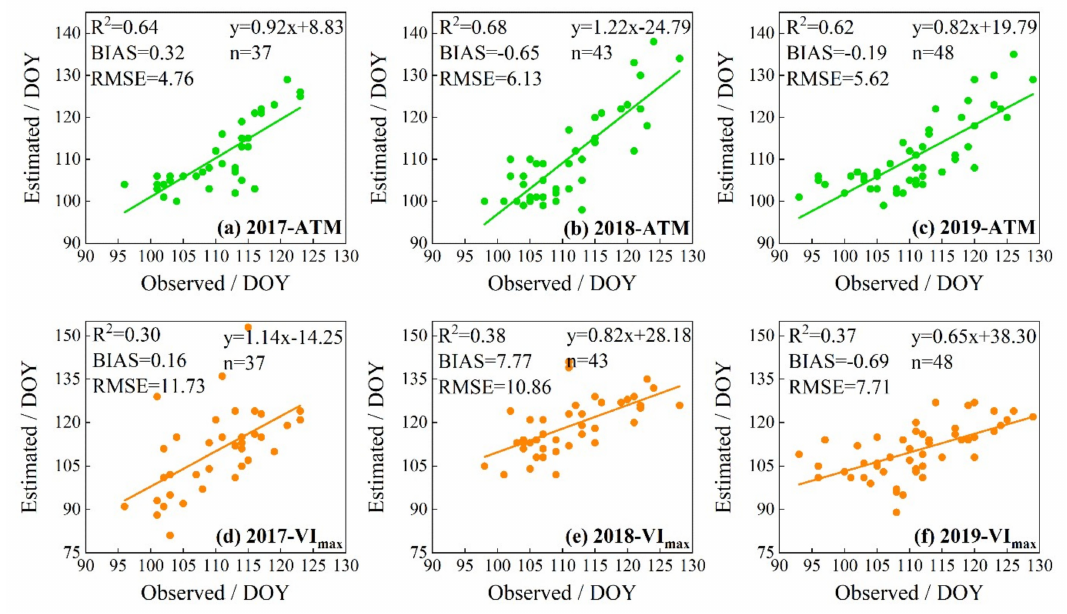
Figure 5. Scatter plot between observed heading dates and estimated ones. ( a – c ) the proposed ATM method for 2017, 2018 and 2019, respectively; ( d – f ) the VI max method for 2017, 2018 and 2019, respectively. DOY: Julian day of year.